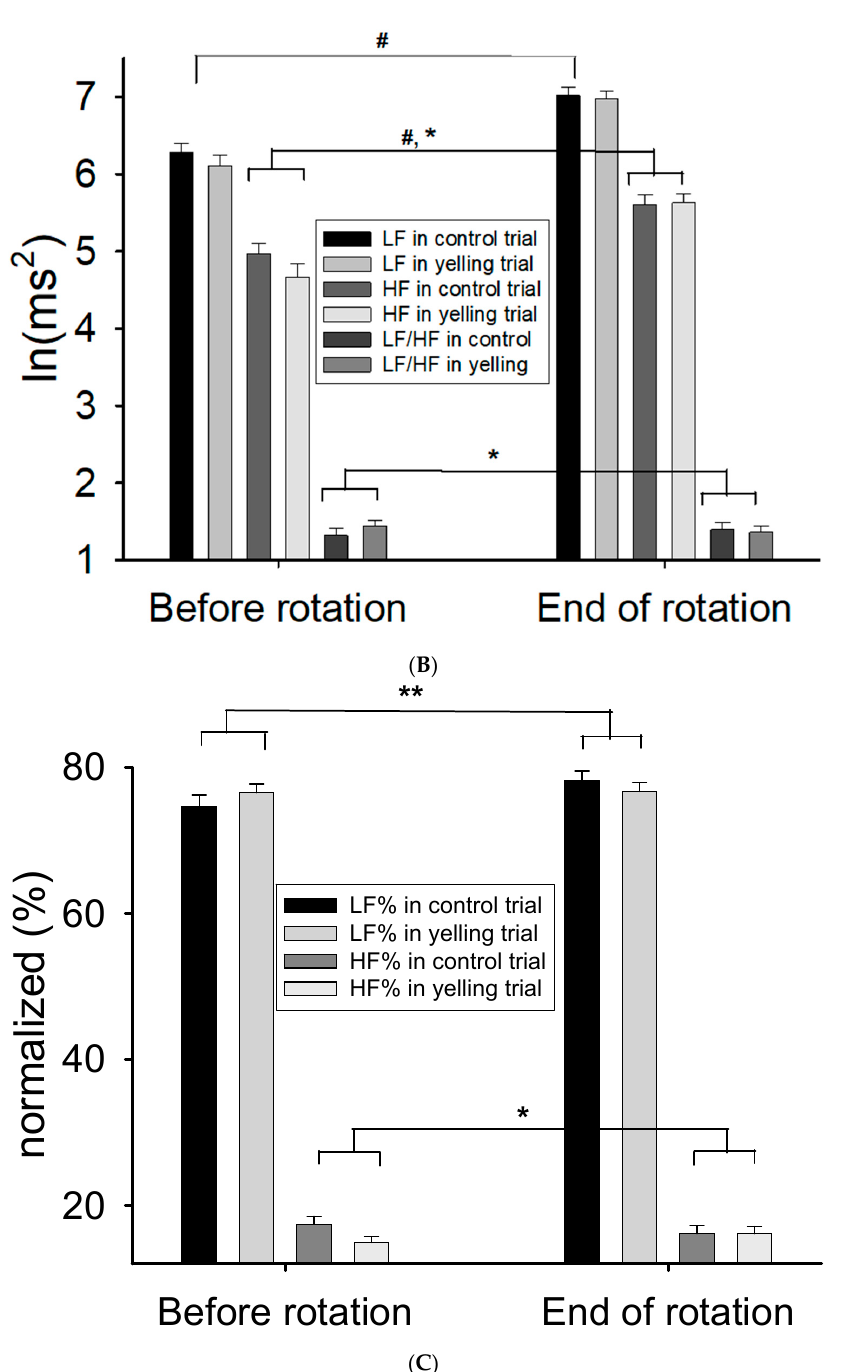
Figure 3. Effect of the yelling intervention on blood pressure and HRV responses during Coriolis stimulation. ( A ) Both systolic blood pressure (SBP) and diastolic blood pressure (DBP) increased significantly after Coriolis stimulation. ( B ) The activities of LF and HF both increase significantly after rotational stimulation, and yelling had a trend of time-by-trial interaction in HF and LF/HF ratio. ( C ) Yelling had a significant time-by-trial interaction in LF%, whereas it had a trend of time- by-trial interaction in HF%. Data are presented as mean ± SEM. # p < 0.05, a significant time effect; * 0.05 < p < 0.09, a trend of time-by-trial interaction; ** p < 0.05, a significant time-by-trial interaction